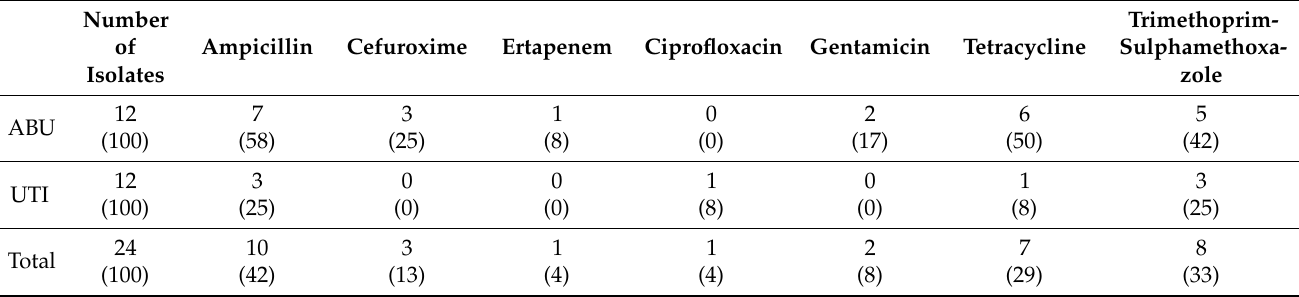
Table 1. Prevalence of antibiotic resistance in E. coli isolates from patients with asymptomatic bacteriuria (ABU) and urinary tract infection (UTI). Numbers indicate number of E. coli isolates in total or number of isolates resistant towards antibiotic shown